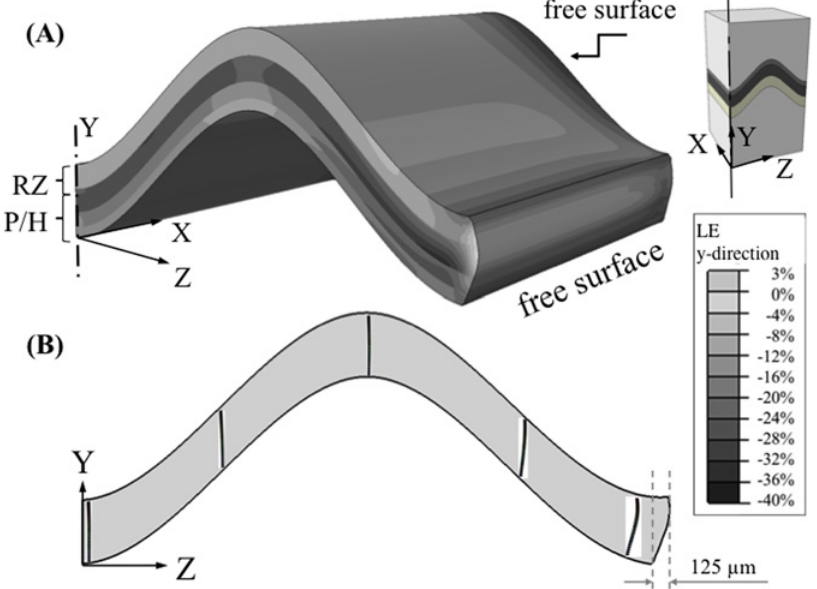
Fig 4. Distribution of the axial logarithmic strain and deformation of the chondrons. (A) A non-uniform distribution of axial logarithmic strain, in the y-direction, exists within the ‘ m ’ shape growth plate in the mesoscopic model. Chondrocytes were not included in this model. The distribution of strain was significantly different at these locations from the central or internal regions of the growth plate and reached values approaching double the nominal engineering strain of 20%; (B) Deformed chondrons obtained from the microscale model with cellular detail is overlaid on a deformed macroscale model displaying only the growth plate. Chondrons buckled within 300 μ m of free surfaces, but not within the growth plate interior when 20% overall compressive strain was applied across the macroscale model. Deformed models are not scaled up. The ‘ m ’ shape growth plate exhibited transverse outward buckling deformation of 125 μ m at the edge. The contour plot is obtained by extrapolating the integration point values to the nodes and then